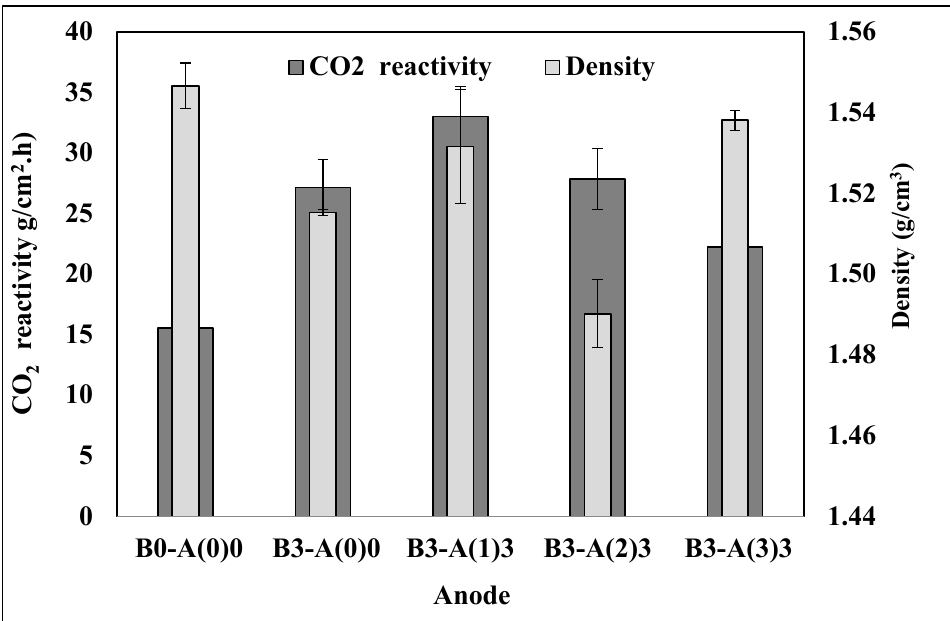
Figure 5. CO 2 reactivity of anodes.